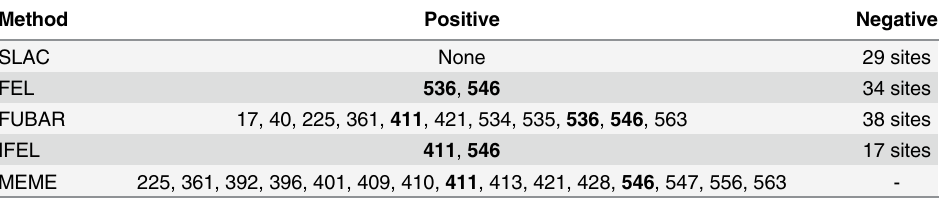
Fig 2. Alignment of VP1/VP2 amino acid changes with respect to the prototype strain (human bocavirus [hBoV] st1; DQ000495) in 105 Italian hBoV strains. Dots indicate identity. Amino acids highlighted in bold are under positive selective pressure. The bar length corresponds to the viral load levels. The viral load levels of strains with the T590S change and an additional change in a codon under positive selection are marked with an asterisk. doi:10.1371/journal.pone.0135640.g002 Table 2. Positively and negatively selected sites for human bocavirus strains originating from this